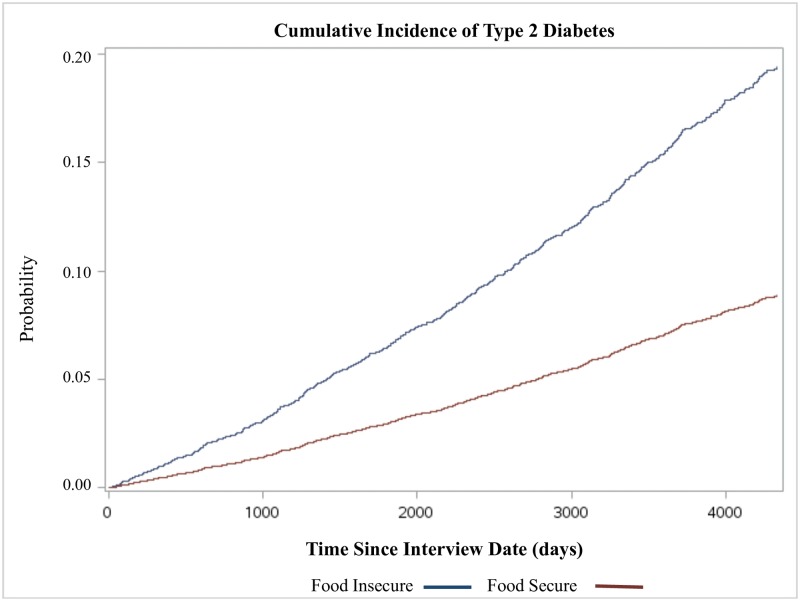
Cumulative incidence of type 2 diabetes by food security status, household population aged 18 or older, Ontario (n = 4,739), CCHS 2004 (Cycle 2.2).